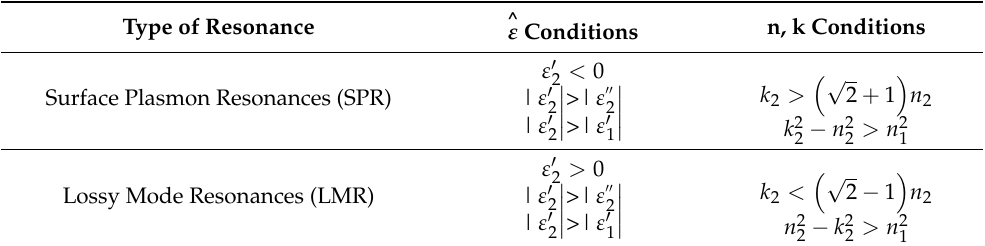
Table 1. Conditions for the generation of SPRs and LMRs ( ε 1 , n 1 , and k 1 represent the permittivity, refractive index and extinction coefficient for the substrate, whilst ε 2 , n 2 , and k 2 represent the permittivity, refractive index and extinction coefficient for the thin film).